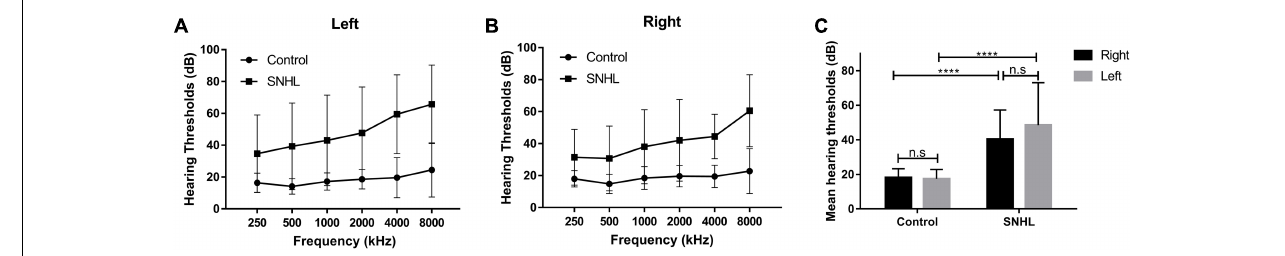
FIGURE 1 | The hearing thresholds of (A) right side and (B) left side at 250, 500, 1000, 2000, 4000, and 8000 Hz in the control and SNHL groups. (C) No side differences in mean hearing thresholds are shown for either group. The mean hearing thresholds for each side in patients with SNHL are significantly higher than in healthy controls. The data are shown as mean ± standard deviation. ∗∗∗∗ p <